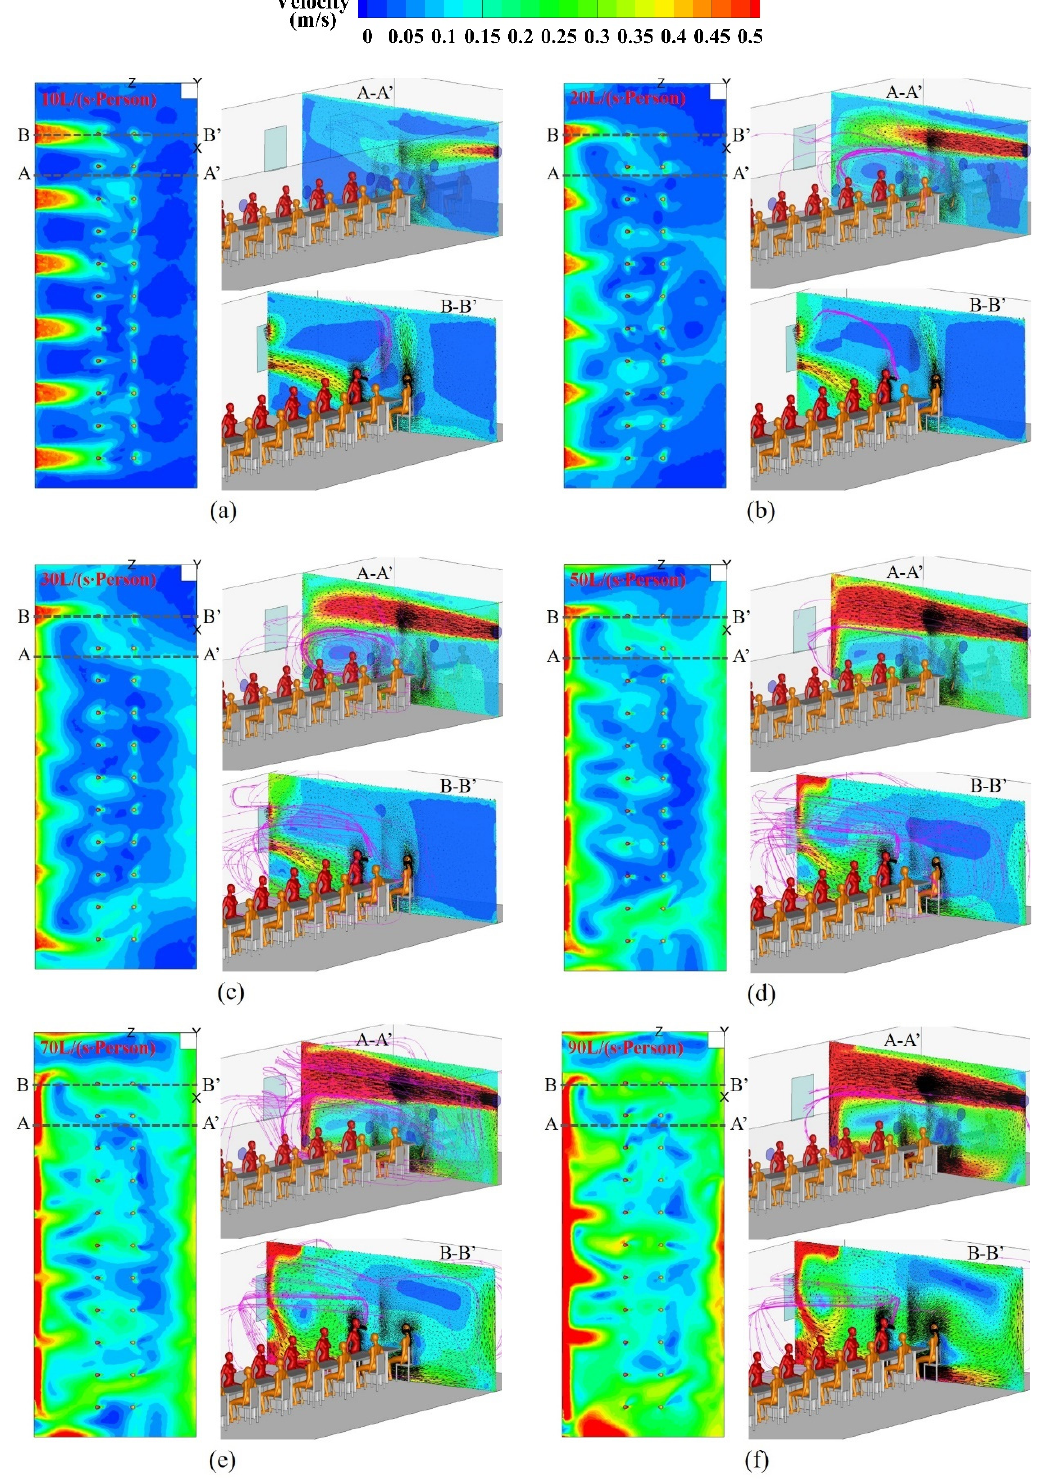
Figure 15. Airflow patterns at the planes of y = 1.1 m, x = 1.09 m, and x = 2.25 m under the MSFV without partition and with different ventilation rates: ( a ) 10 L/(s · Person); ( b ) 20 L/(s · Person); ( c ) 30 L/(s · Person); ( d ) 50 L/(s · Person); ( e ) 70 L/(s · Person); ( f ) 90 L/(s · Person).